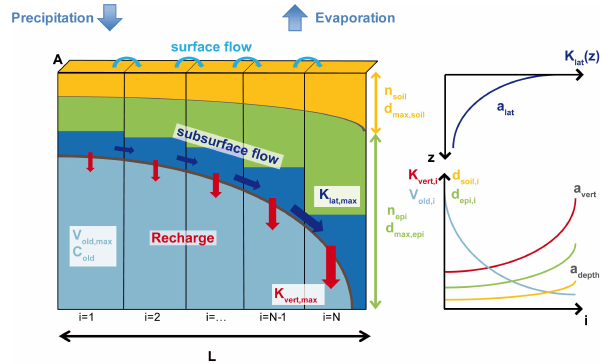
Fig. 3. Model structure and parameters; parameter a lat controls the decay of K lat,max with depth z , and parameters a vert and a depth control the variability of K vert,max , V old, max , d soil,max and d epi,max among the N